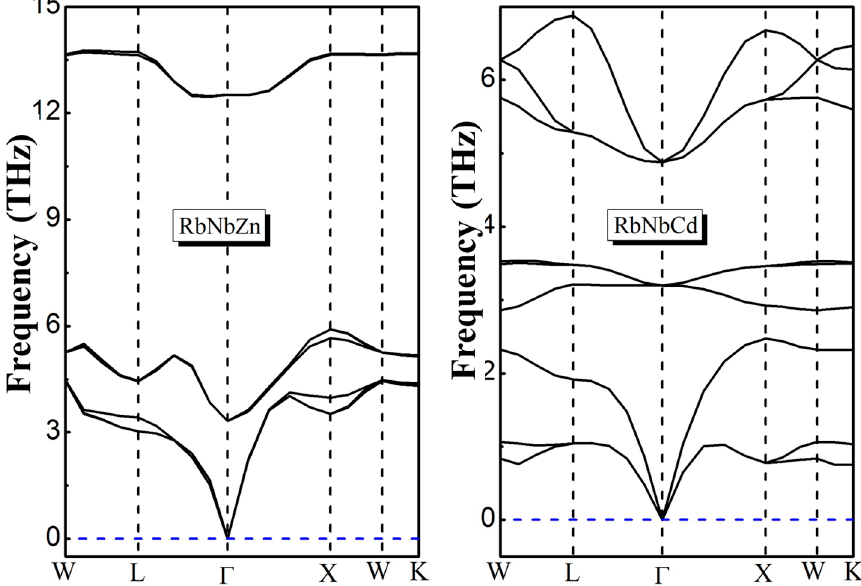
Figure 3. Calculated phonon dispersion for RbNbCd and RbNbZn along the high-symmetry axes of the first Brillouin zone. Table 2. Computed elastic constants (C ij ) (in GPa), elastic modulus (B, G and E) (in GPa), Poisson’s ratio (v), G/B, Cauchy pressure and shear anisotropic